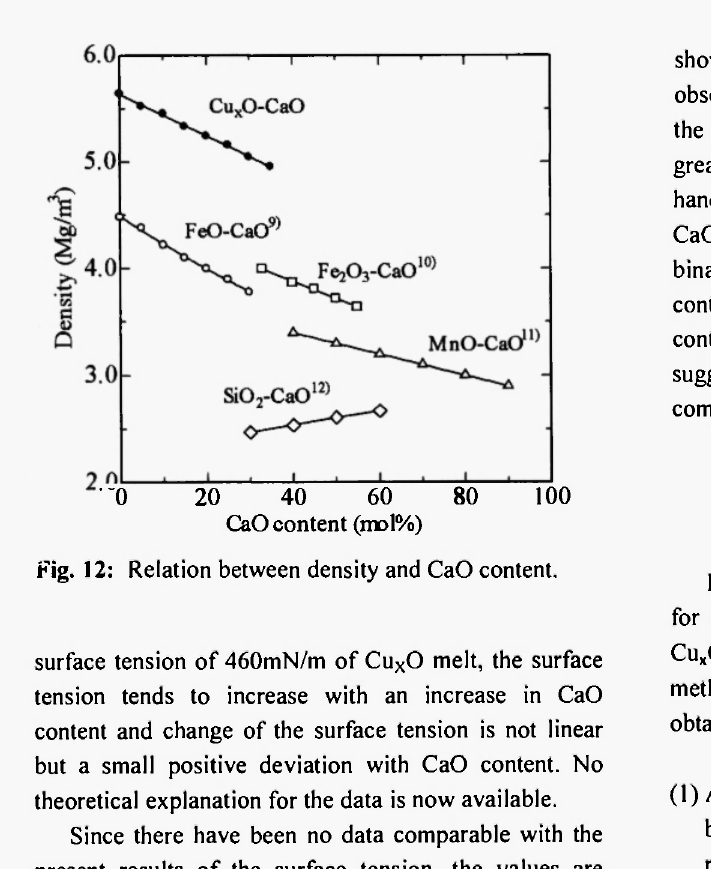
Fig. 13. The hypothetical surface tension value of CaO